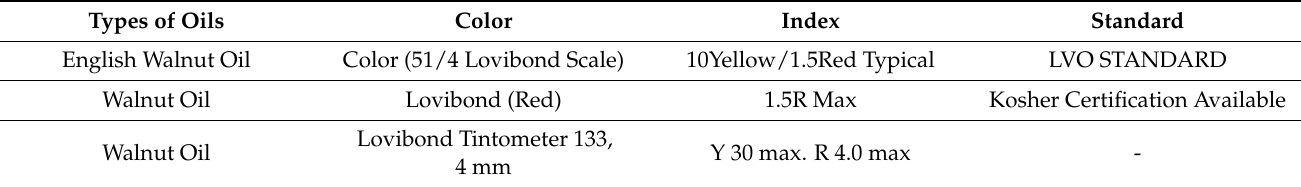
Table 13. Standard colors of walnut